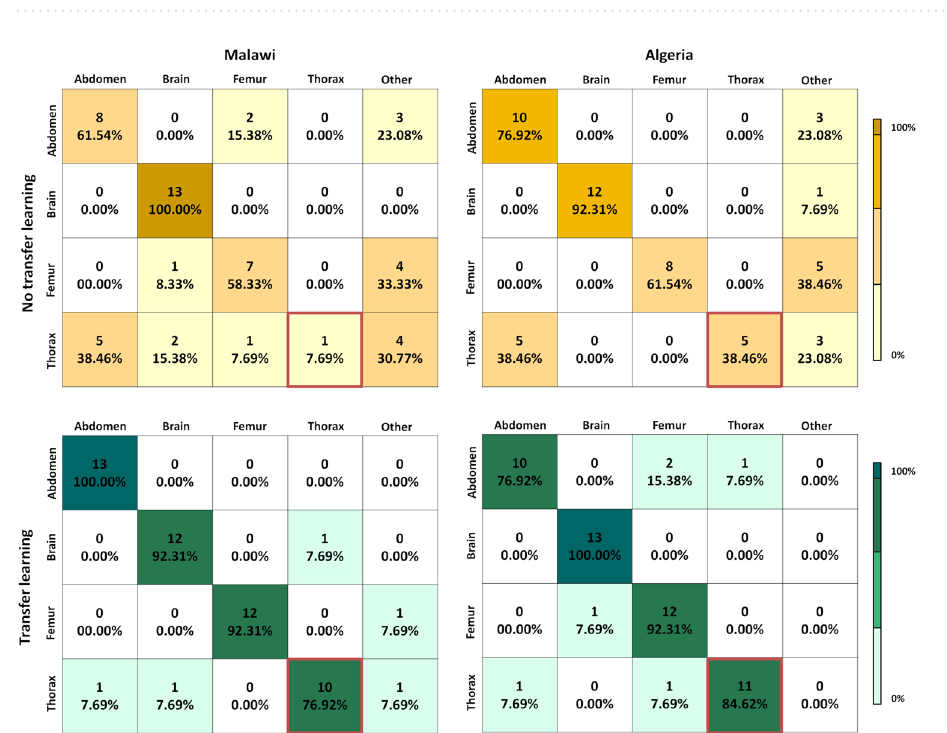
Figure 5. Results on common plane classification with and without transfer learning using 12 patients of each African centre in Malawi and